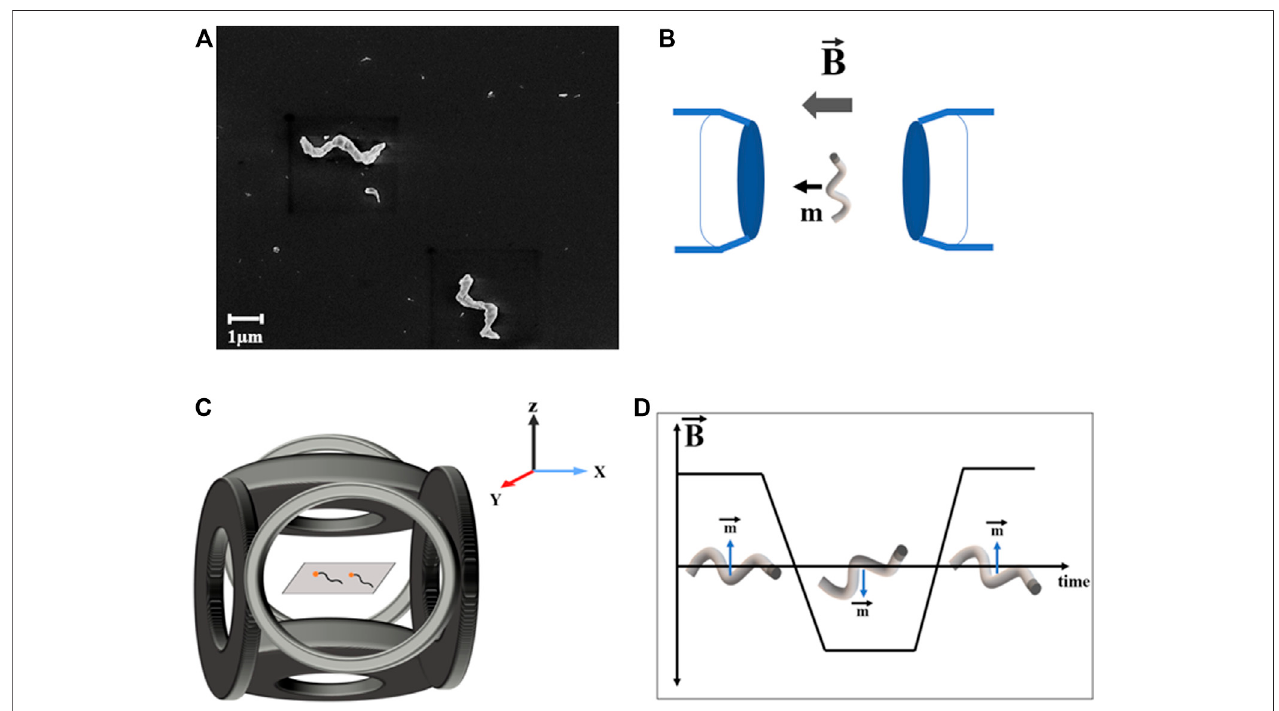
FIGURE 1 | (A) . SEM image of the helical swimmers. (B) . A dc- fi eld magnetizes the swimmer with permanent magnetic moment along the short axis. (C) . The schematicofatriaxialHelmholtzcoil,whichenablesauniformmagnetic fi eldatthecenterofthecoil.Theswimmersareplacedinthesamplechamberatthecenterofthe coil. (D) . The oscillating magnetic fi eld in the z -direction causes the back-forth motion of the